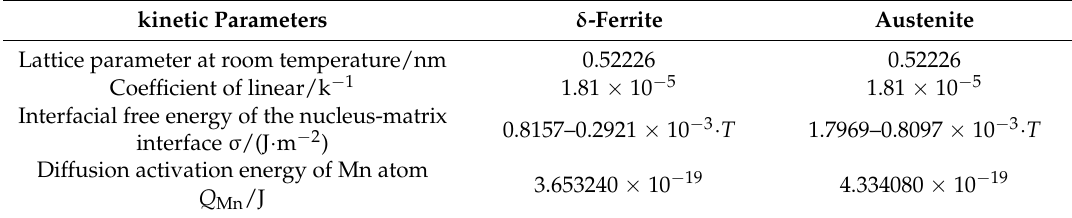
Table 5. Main kinetic parameters of MnS formation in steels